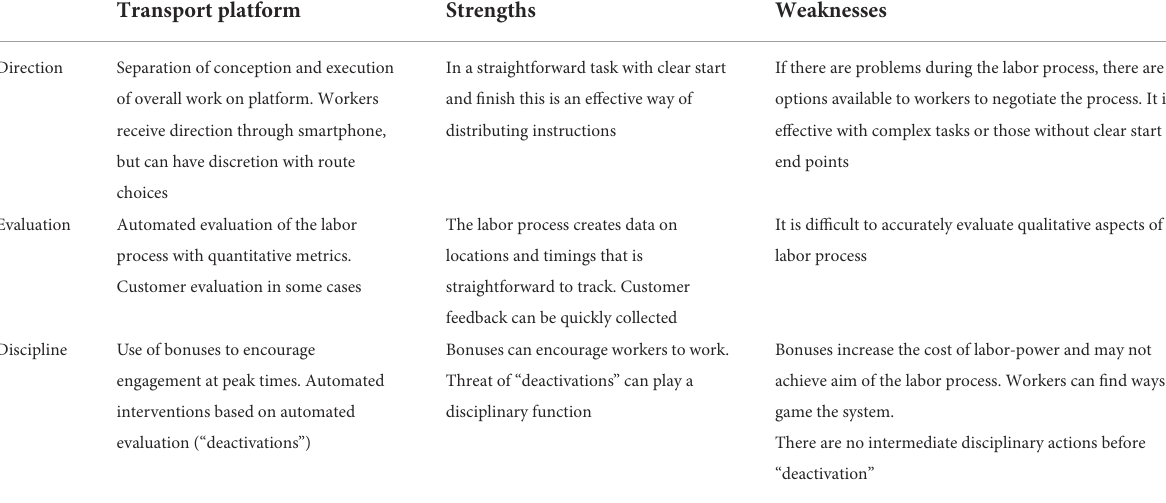
TABLE 2 Algorithmic systems of control. Transport platform Strengths